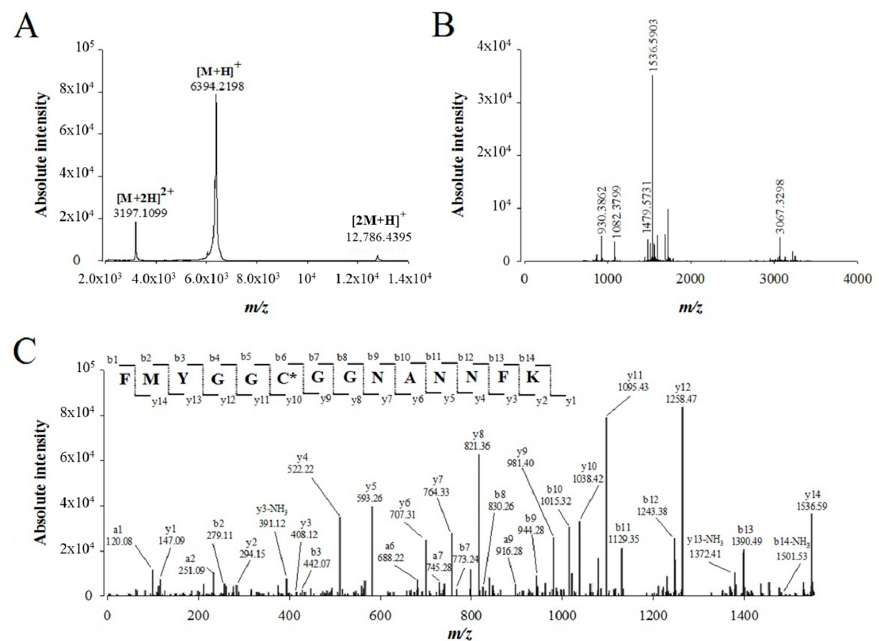
Figure 4. De novo sequencing of compound 1 from fraction F11 by MALDI-TOF/TOF MS/MS after reduction, alkylation and protease digestion. ( A ) MALDI-TOF MS of compound 1 (linear positive mode). ( B ) MALDI-TOF MS of compound 1 after reduction, alkylation and trypsin digestion (reflectron positive mode). ( C ) MALDI-TOF/TOF MS/MS of precursor ion m/z 1536.5903. The peptide sequence FMYGGC*GGNANNFK is derived by de novo sequencing. Peaks corresponding to the y, b and a ions from this peptide are labeled on the spectrum. The cysteine marked in the sequence with a star bears carboamidomethyl modification thanks to alkylation. As a result of the different ion sequencing (three in total), MALDI-TOF/TOF MS/MS covered 41 amino acids which represent 71.9% of the full sequence (Table 1). Table 1. List of walterospermin sequences obtained after MS/MS analyses of the reduced/alkylated/digested peptide. Alkylation is witnessed by an additional mass of 57.02 Da.